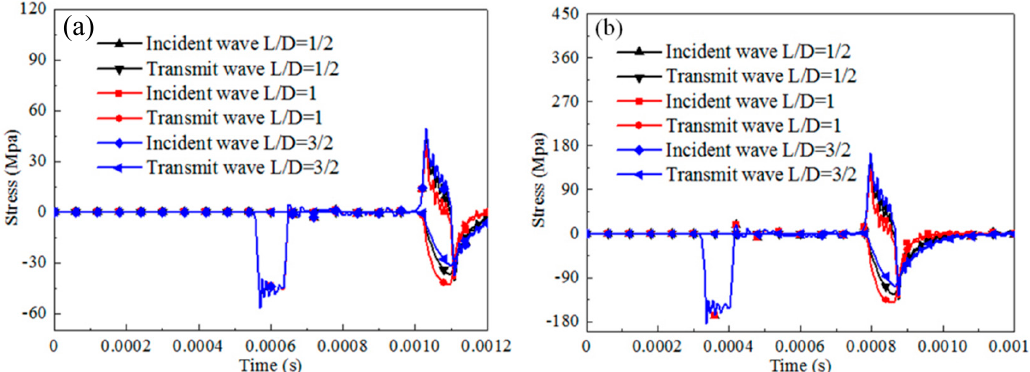
Figure 14. Comparison of the reflected and transmitted waves for different configurations of cylinder specimens with rate-dependent viscoelasticity material (u = 0). ( a ) Impact velocity of 3 m/s, ( b ) impact velocity of 10 m/s.